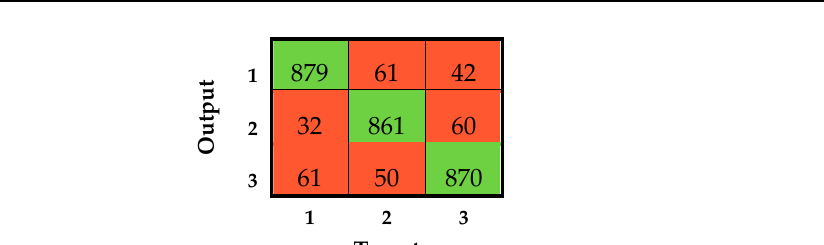
Figure 7. Confusion matrix related to the SH a SVM q considering all subjects together. 1, 2, and 3 stand for regular, loss of contact, and knee-bent condition, respectively. Numbers in green cells represent the correct classifications, while those in red cells are misclassifications.